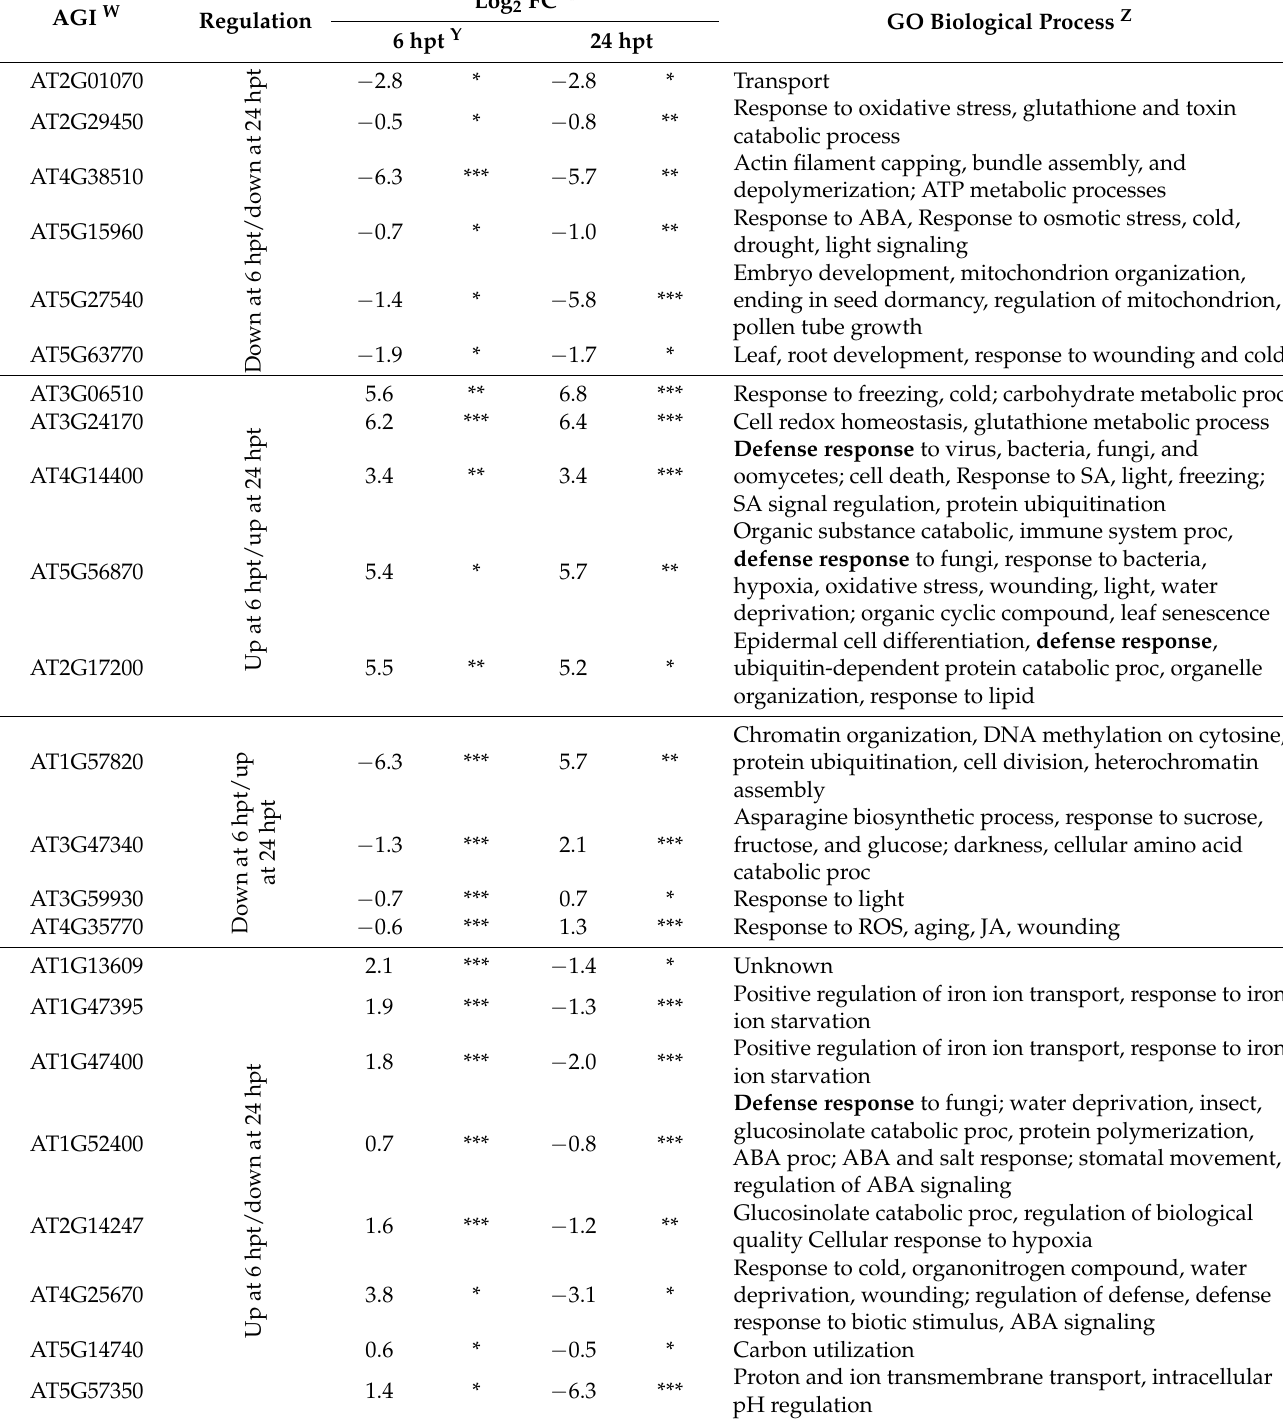
Table 1. Shared differentially expressed genes (DEGs) at 6 and 24 hpt with